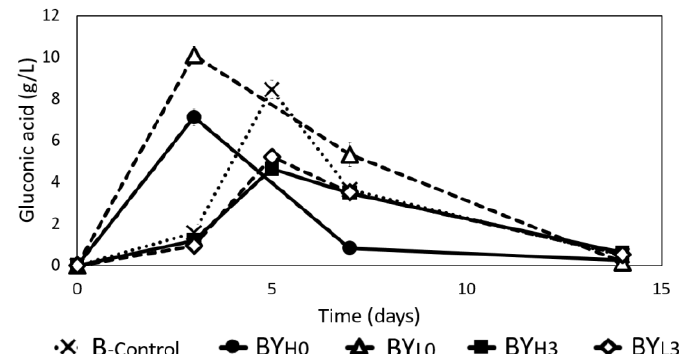
Figure 5. Changes in gluconic acid during 14 days of cultivation using K. intermedius mono- (B -control ) and co-cultures with D. bruxellensis at 30 ◦ C. D. bruxellensis was added simultaneously at concentra- tions of 10 6 CFU/mL (BY H0 ) and 10 3 CFU/mL (BY L0 ) and sequentially at 10 6 CFU/mL (BY H3 ) and 10 3 CFU/mL (BY L3 ).